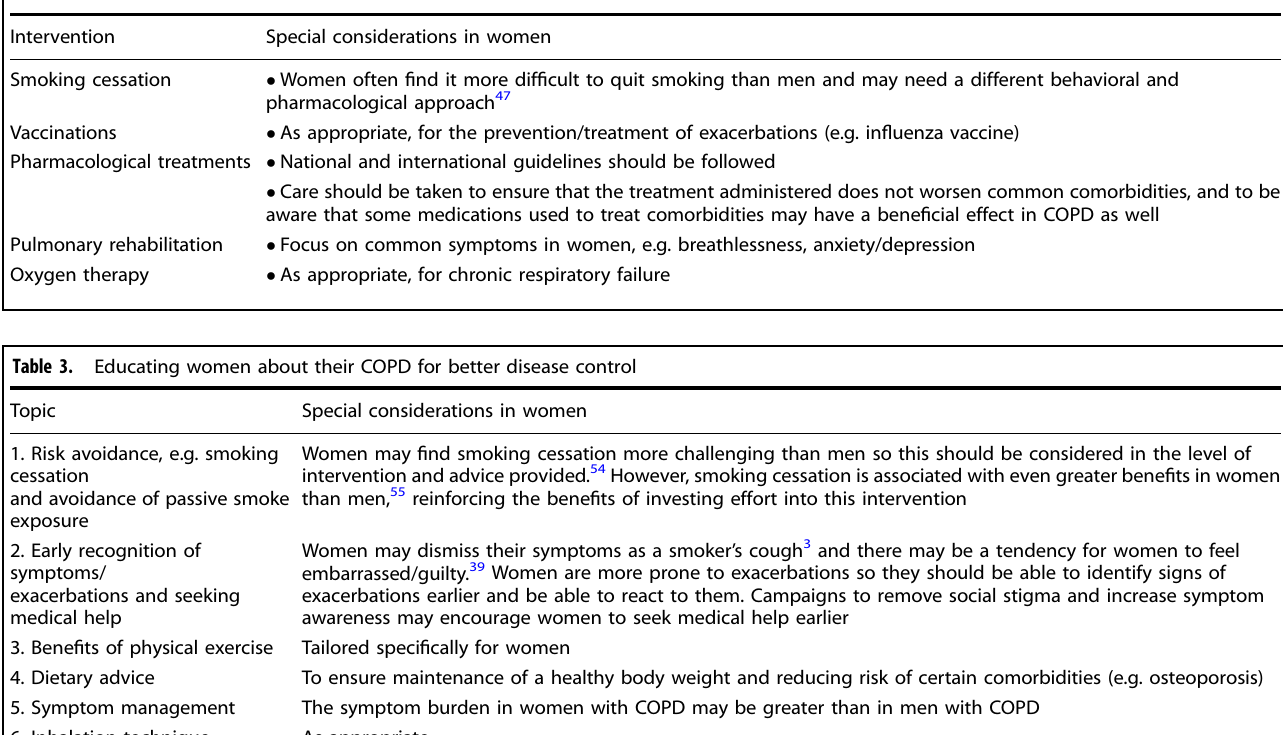
Table 2. Considerations for COPD interventions in women Intervention Special considerations in women Smoking cessation